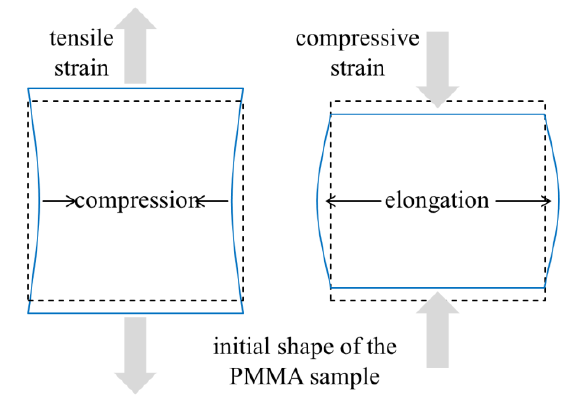
Figure 4. Schematic illustration of the deformation of the PMMA sample caused by tensile strain ( Left ) and compressive strain ( Right